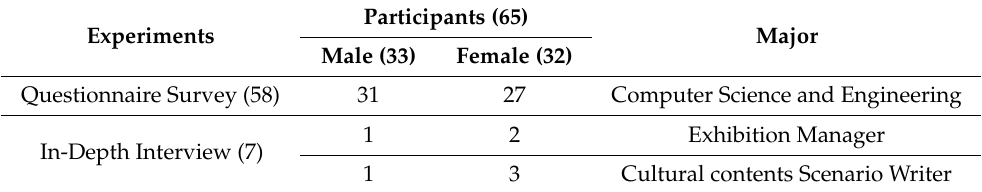
Table 1. Participant Information.